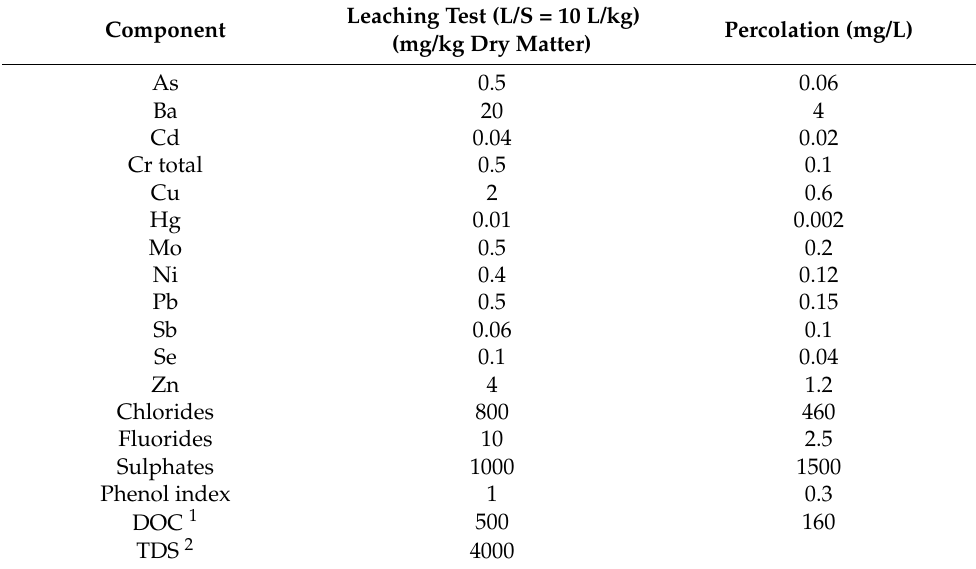
Table 2. Leaching limits for inert